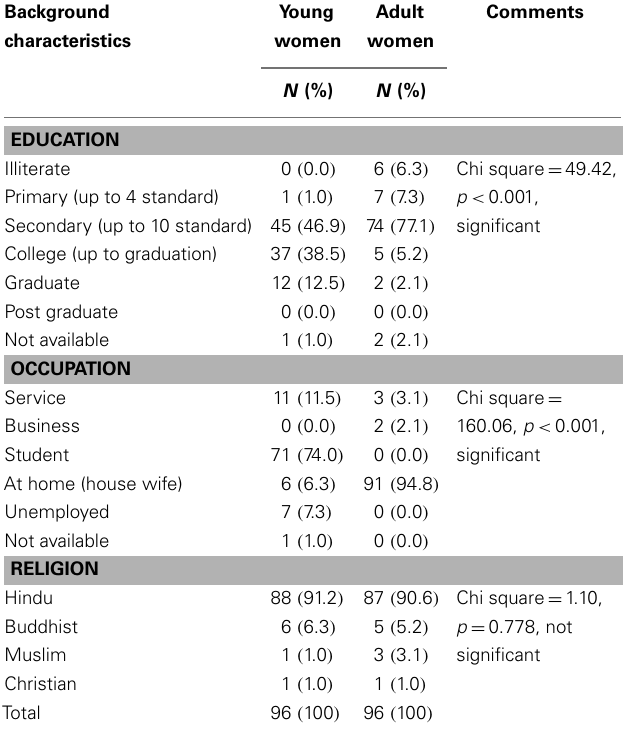
Table 1 |The profile of the selected participants . Table 2 | Perceptions of 96 adult women and 96 younger women about menstruation issues* .